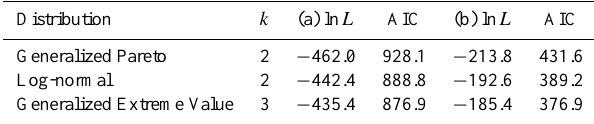
Table 3. The maximum values of the log-likelihood function (ln L ) and the corresponding values of the AIC for the model distribu- tion functions considered to fit (a) the rescaled distributions given in Fig. 2b and (b) the rescaled distributions given in Fig. 4. k is the number of parameters for the considered distribution. The values correspond to the fitting analysis considering only calderas/paterae with an area above 30km 2